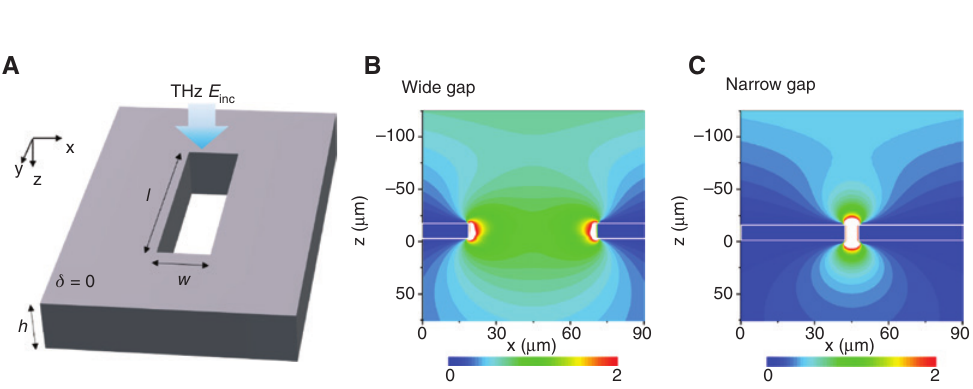
Figure 13: Field enhancement in a rectangle slot. (A) Schematic of single rectangular hole punctured onto a metallic thin film with a length l and a width w and a thickness of h is irradiated by THz incidence. Transmitted THz field distributions for wide gap (B) and narrow gap (C) calculated by FDTD